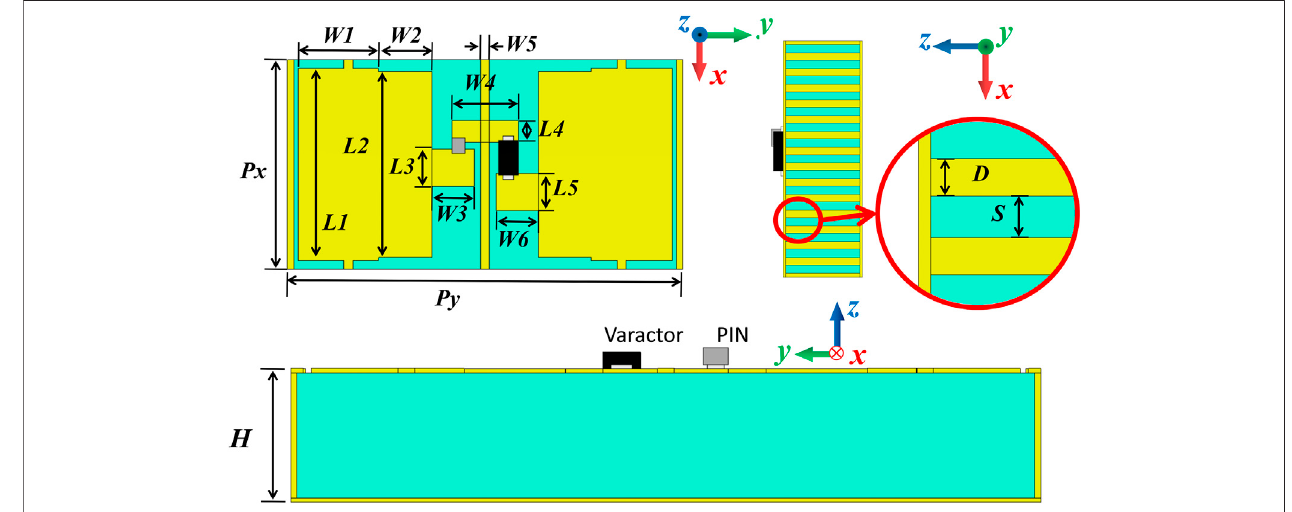
FIGURE 2 | The three-view of the proposed programmable element.